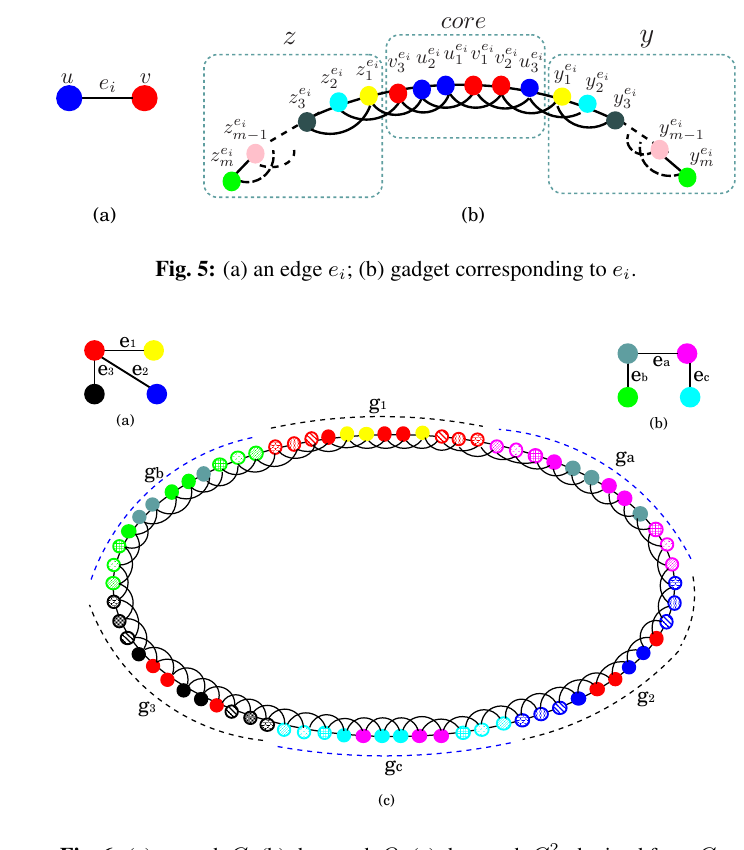
Fig. 6: (a) a graph G ; (b) the graph Q ; (c) the graph C 2 n obtained from G